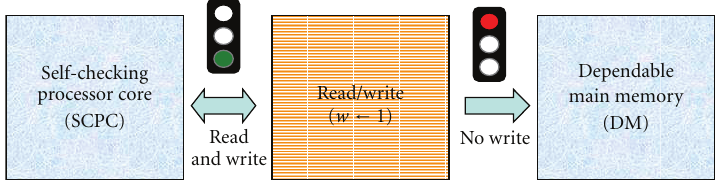
Figure 12: SCHJ relations in mode 01.